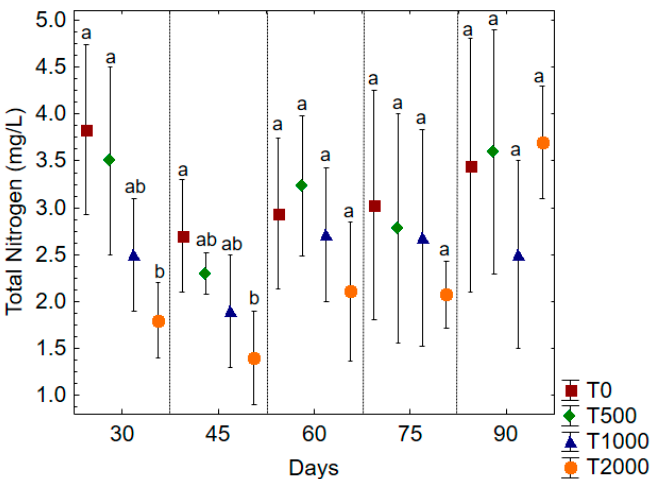
Figure 3. Mean ( ± SD) of total nitrogen throughout the experimental period of 90 days. T0: shrimp monoculture (100 shrimp/m 2 ); T500: 100 shrimp/m 2 and 500 g/m 2 of G. birdiae ; T1000: 100 shrimp/m 2 and 1000 g/m 2 of G. birdiae ; T2000: 100 shrimp/m 2 and 2000 g/m 2 of G. birdiae . Different letters indicate a significant difference between treatments according to the Tukey test ( p < 0.05).